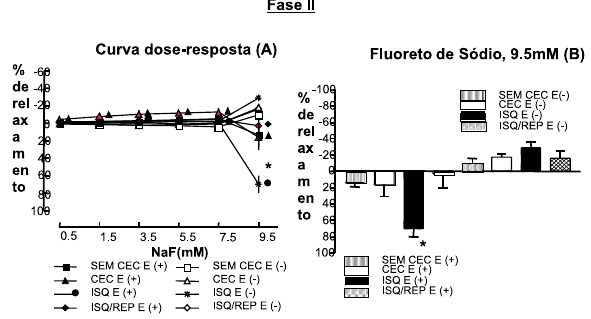
Fig. 5 - Fase II (Krebs sem magnésio): A - Curvas dose- respostas ao fluoreto de sódio (NaF) em anéis de artérias coronárias caninas, contraídas com PGF